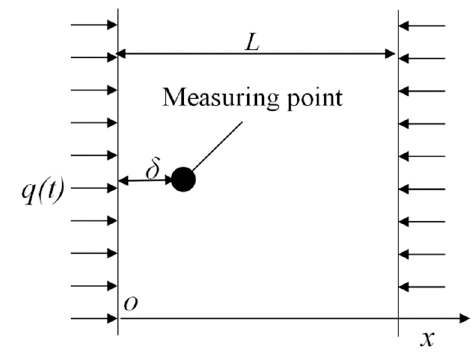
Figure 5. Schematic of the physical model of the inverse heat conduction problem.